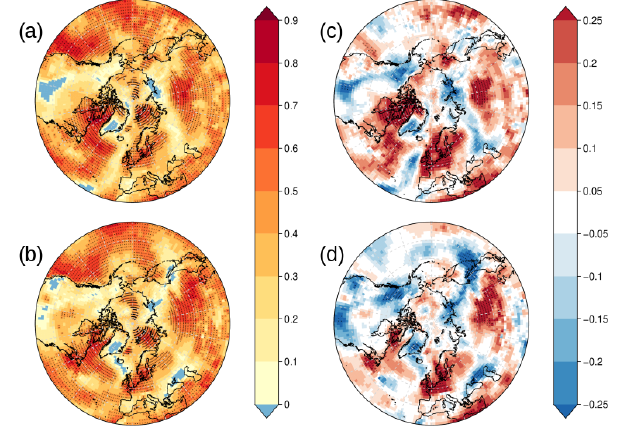
Figure 11. Correlation between the 2m temperature of week 3 and the corresponding observation for the NAO initialized CNRM (a) and ECMWF (b) reforecasts. Panels (c) and (d) depict the correla- tion difference (a) minus Fig. 1c for CNRM and (b) minus Fig. 1g for ECMWF. Stippling indicates significant values at the 95% con- fidence